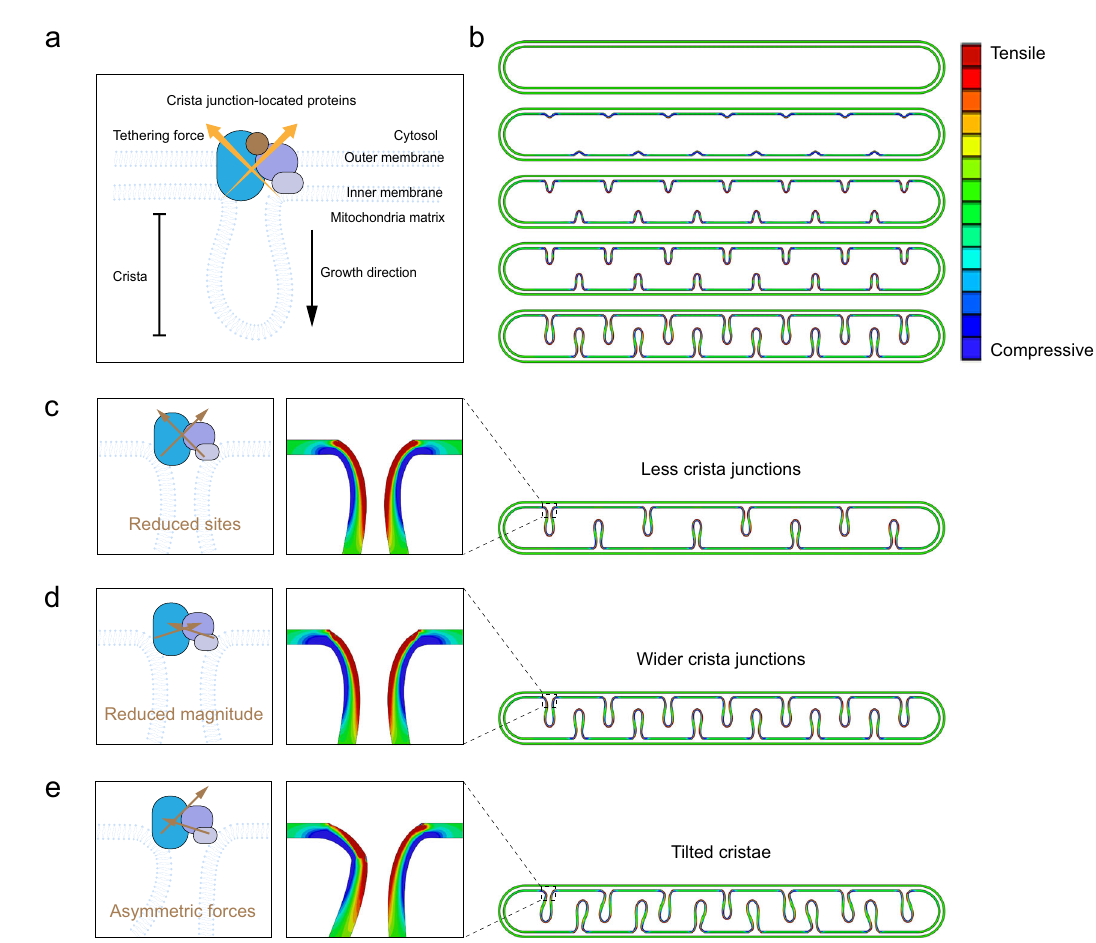
Fig. 1 Mechanical modeling of mitochondria inner membrane reveals the role of constrains at cristae junctions in cristae morphogenesis. a Schematic diagram showing cristae formation. The structure of cristae, cytosol, outer membrane, inner membrane, mitochondria matrix and cristae junctions (CJs)- located proteins are illustrated. CJ-located proteins exerted tethering force on CJs. b Mechanical modelling of cristae growth under normal conditions. CJ- located proteins exerted tethering force on CJs and initiated inner membrane ridges. Color bar: membrane stress. c Lack of key CJ-located protein resulted in reduced sites of tethering force and less CJs. Left: schematic diagram showing CJ with tethering site. Right: mechanical modelling of decreased CJs ’ number. Color indicates membrane stress. d Reduced tethering force induced wider CJs. Left: schematic diagram showing CJ with reduced tethering forces. Right: mechanical modelling of wider CJs. Color indicates membrane stress. e Asymmetric tethering force induced tilted crista. Left: schematic diagram showing CJ with symmetric tethering force. Right: mechanical modelling of cristae with different angles. Color indicates membrane